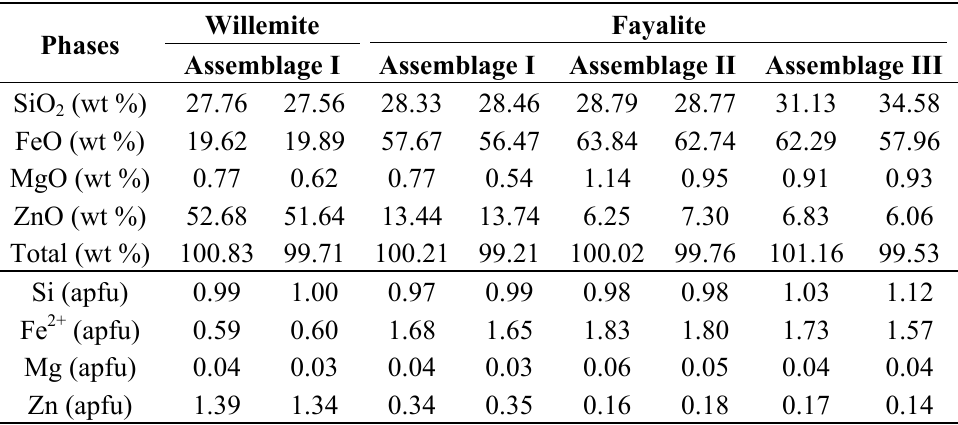
Table 2. Chemical compositions of willemite and fayalite obtained by EDS. Structural formulae (apfu: atoms per formula unit) were calculated on the basis of four